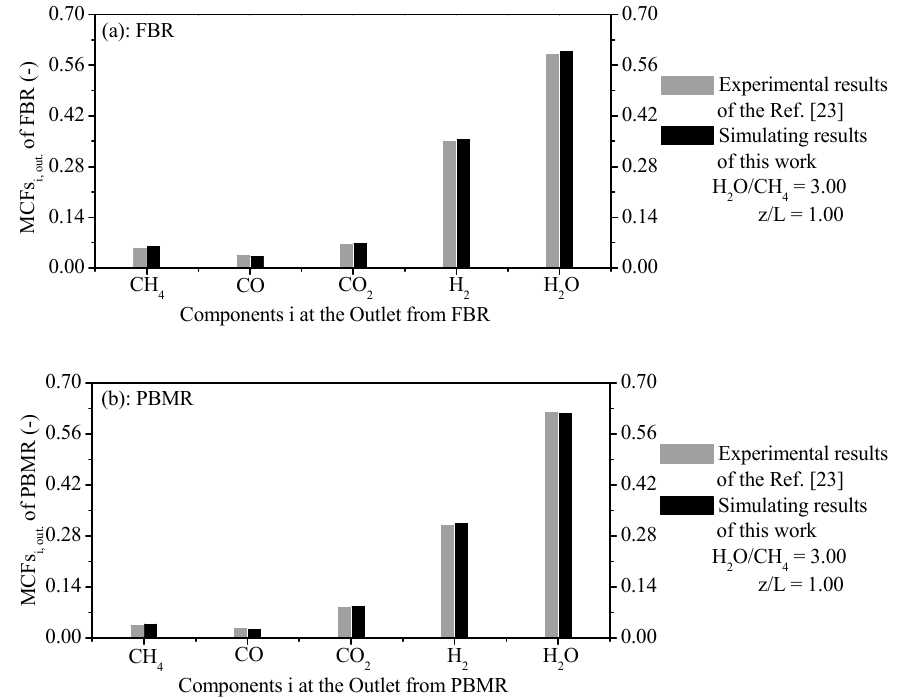
Figure 2. ( a ) Mole fractions of chemical components i at the outlet from Fixed Bed Reformer (FBR); ( b ) Mole fractions of chemical components i at the reaction zone’s outlet from PBMR.